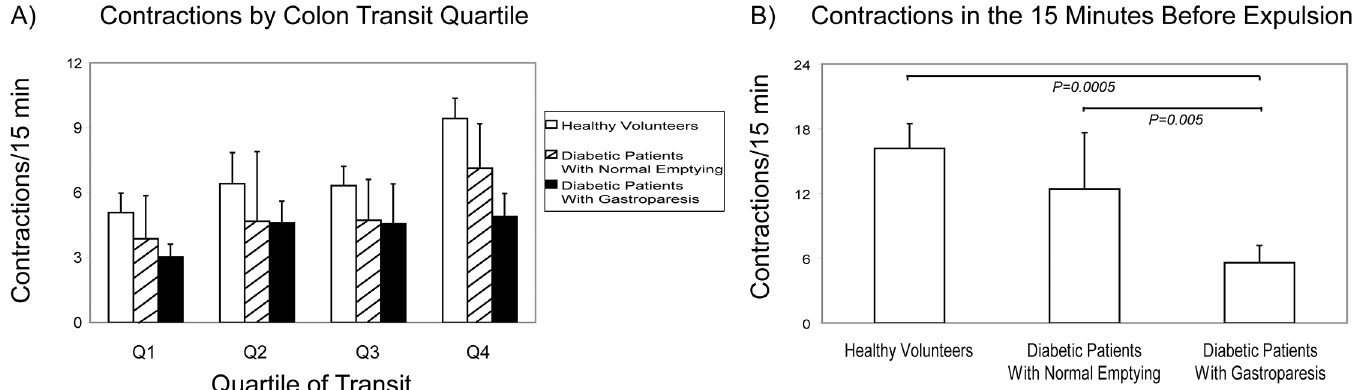
Fig 5. Regional Differences in Numbers of Colon Contractions. Numbers of colon contractions are plotted as a function of colon transit quartile (A) and for the final 15 minutes of colon transit (B). Healthy volunteers (P < 0.0001) and diabetics with normal gastric emptying (P = 0.04) showed increased numbers of contractions from the first to fourth quartiles, while contractions did not increase from the first to fourth quartiles in diabetics with gastroparesis (P = NS). Compared to healthy controls, diabetics with gastroparesis exhibited reduced numbers of contractions in the third (P = 0.05) and fourth (P = 0.0006) quartiles. Diabetics with gastroparesis also showed lower numbers of contractions in the fourth quartile than diabetics with normal emptying (P = 0.02). Diabetics with normal emptying exhibited numbers of contractions that were no different from those of the healthy volunteers in any quartile of colon transit (all P = NS). Numbers of contractions in the final 15 minutes were reduced in diabetics with gastroparesis compared to healthy subjects (P = 0.0005) and diabetics with normal gastric emptying (P = 0.005). Numbers of contractions in the final 15 minutes were no different in diabetics without gastroparesis and healthy volunteers (P =